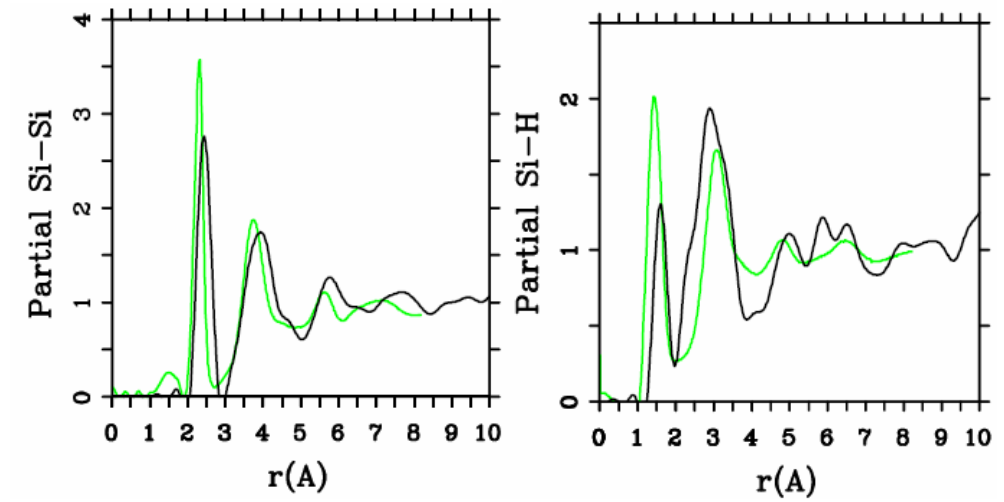
Figure 6. Partial Si–Si and Si–H RDFs for the hydrogenated 10/2 cell. The black lines are our simulation and the green lines are the experimental